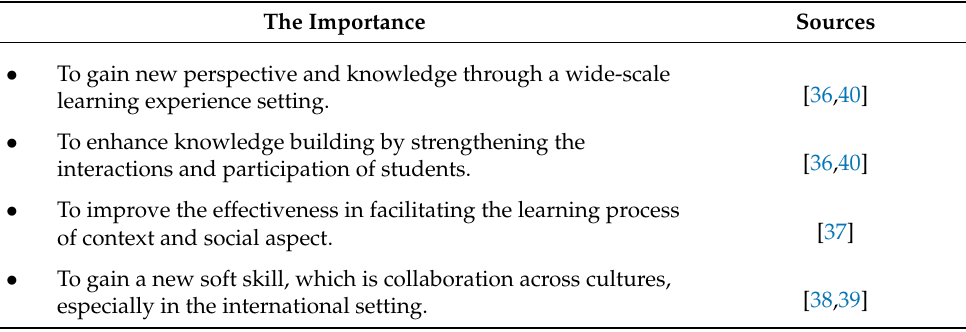
Table 3. The importance of collaborative learning.